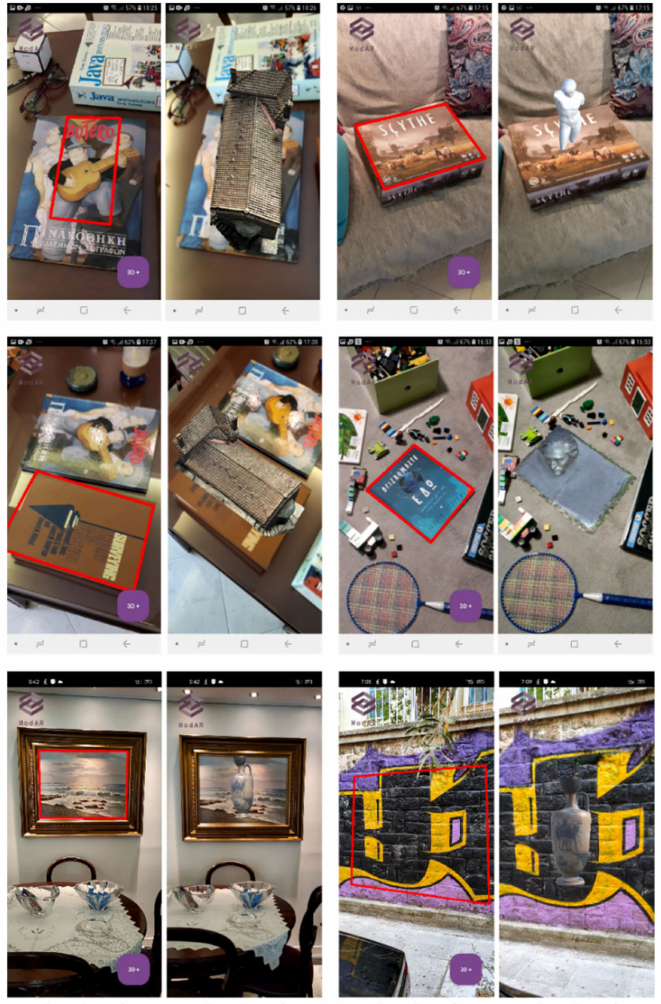
Figure 5. Screenshots from the ModAR prototype illustrating the pattern recognition and AR augmentation